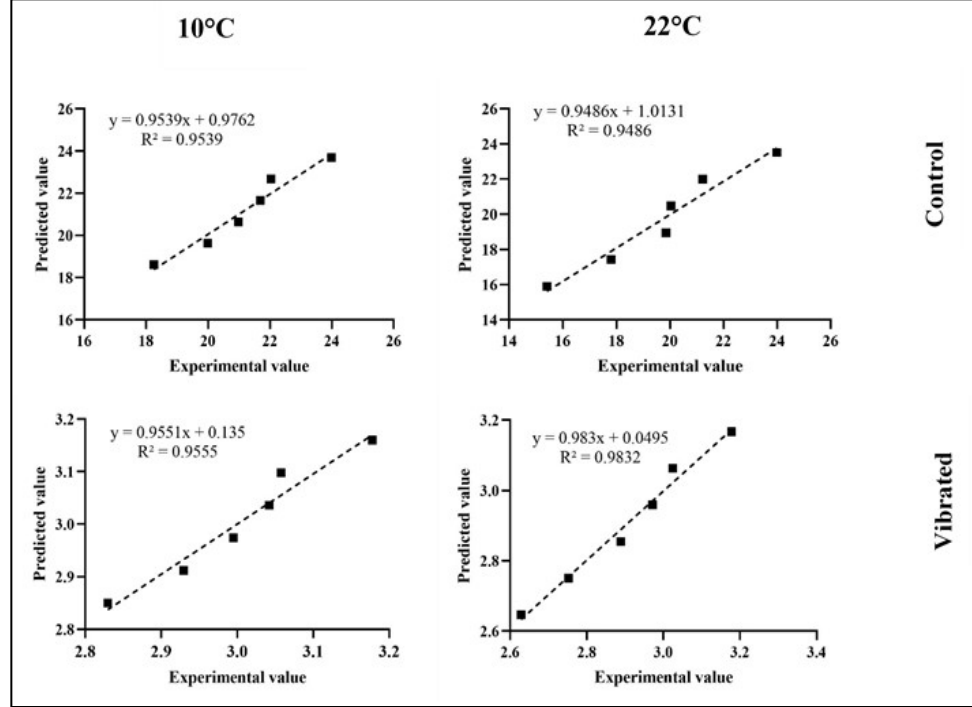
Figure 8. Predicted and experimental results of b* change kinetic of vibrated and non-vibrated (con- trol) tomatoes stored at 10 °C and 22